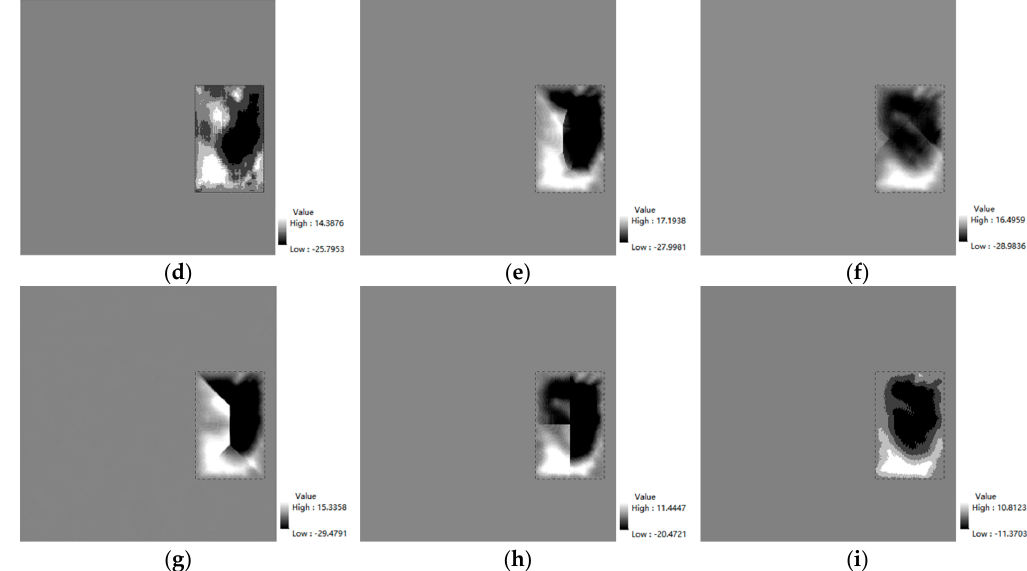
Figure 9. Subtraction calculation. ( a ) Raw DEM data; ( b ) our result; ( c ) raw DEM minus our result; ( d ) raw DEM minus the WGAN result; ( e ) raw DEM minus the IDW result; ( f ) raw DEM minus the RBF result; ( g ) raw DEM minus the EBK result; ( h ) raw DEM minus the Rst result; and ( i ) raw DEM minus the Bicubic result.